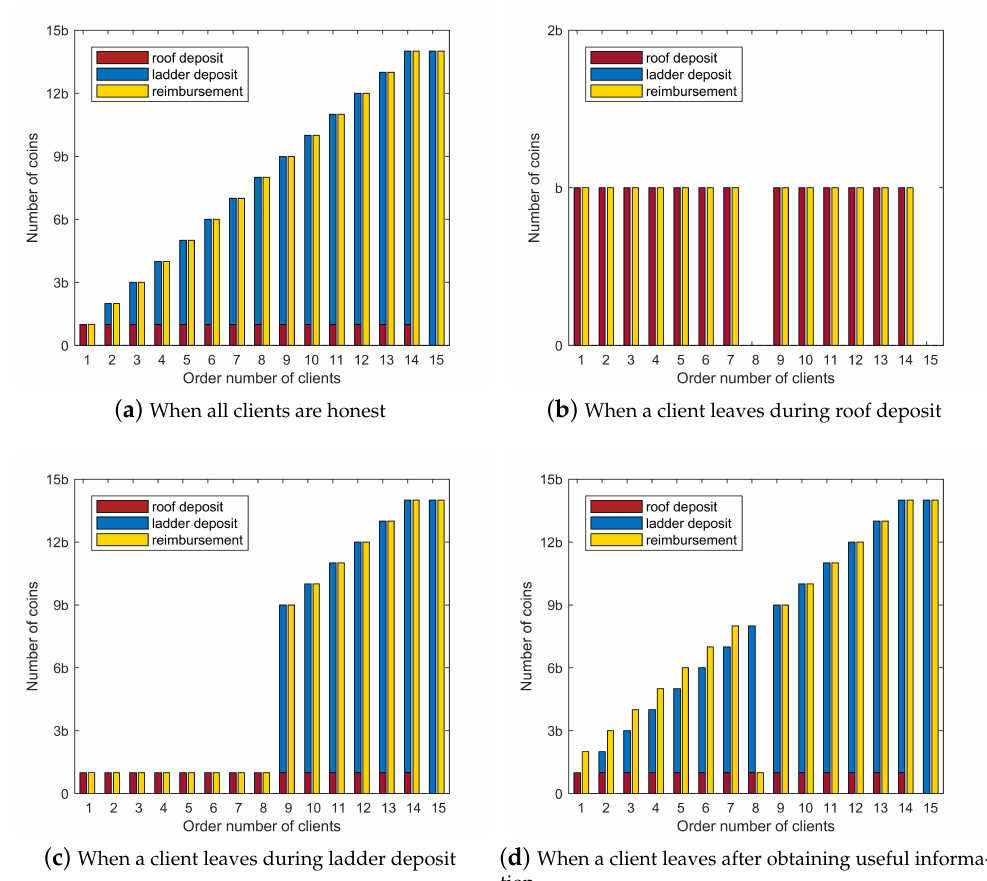
Figure 10. The circulation of digital currencies when there are 15 clients participating in